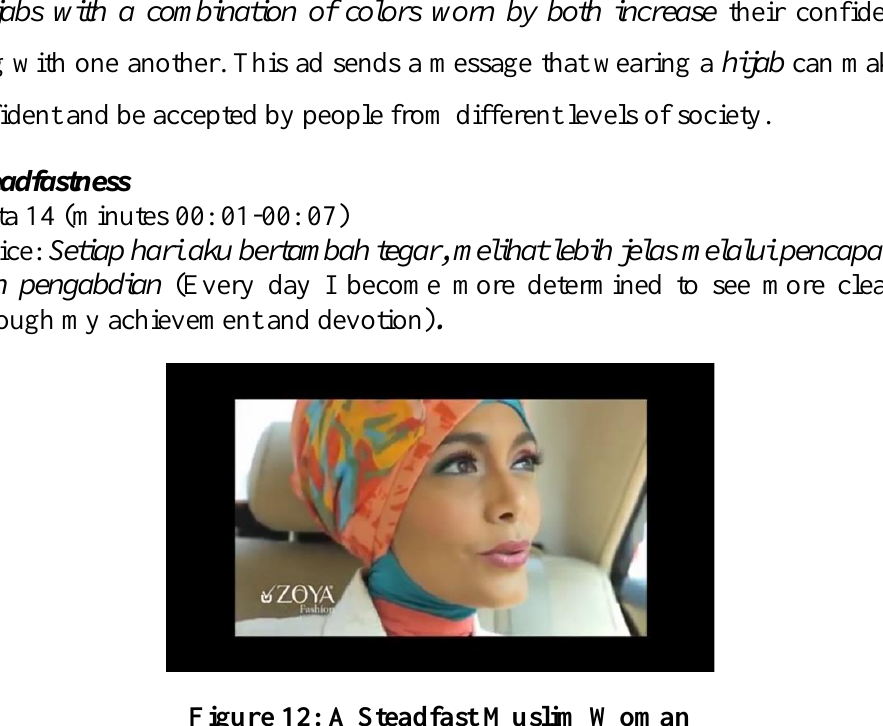
Figure 12: A Steadfast Muslim